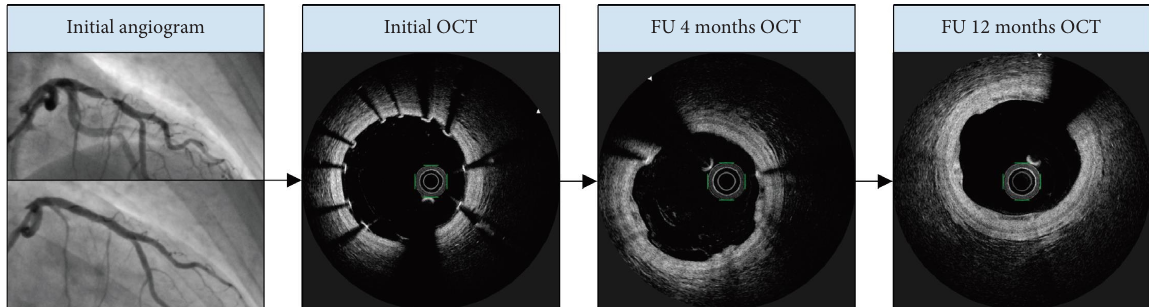
Figure 2: Magmaris implantation procedure with subsequent OCT